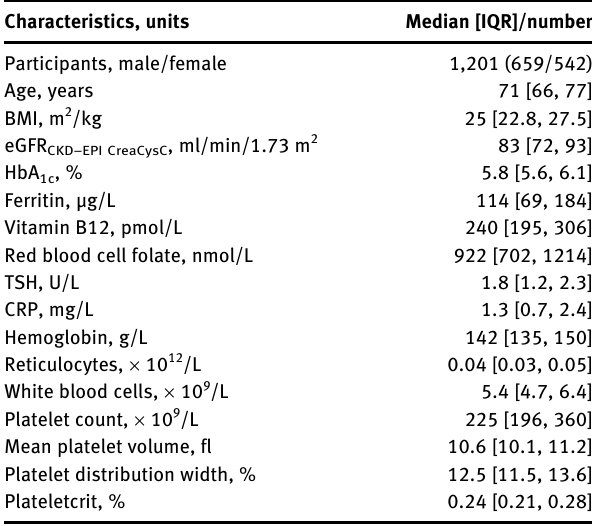
Table  : Participant characteristics in the direct reference interval